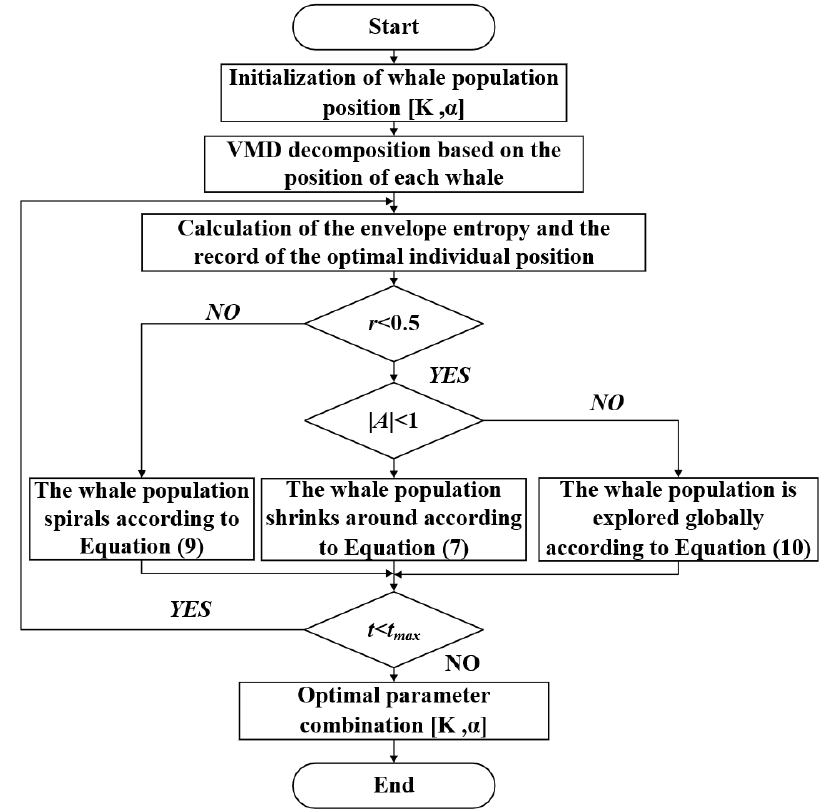
Figure 3. Flowchart of RWOA ‐ VMD.